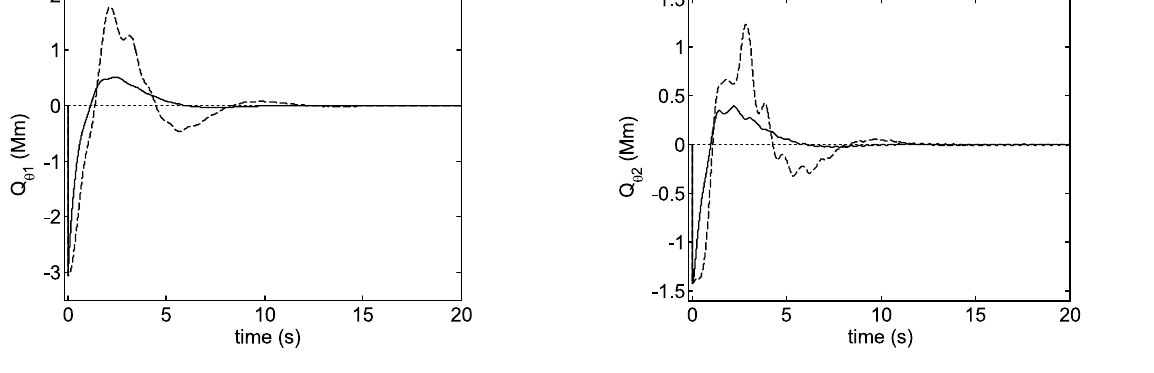
Fig. 16. Control torque Q θ 2 considering same initial conditions (—) and different initial conditions (- - -) for the angular